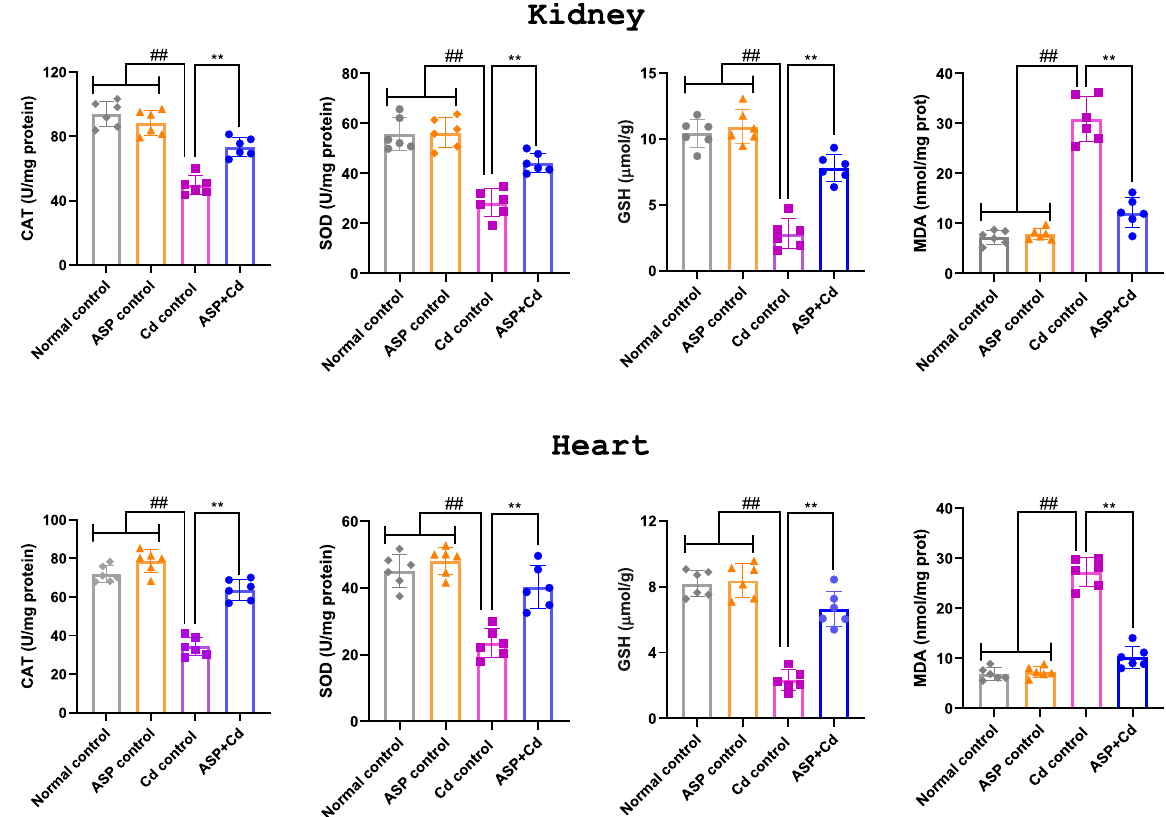
Figure 2. Effects of asperuloside on kidney and heart CAT, SOD, GSH and MDA levels of cadmium administered rats. Histograms represent the mean ± SD (n = 6). For all panels: ## p < 0.05 compared to normal and ASP control groups; ** p < 0.05 compared to Cd control group